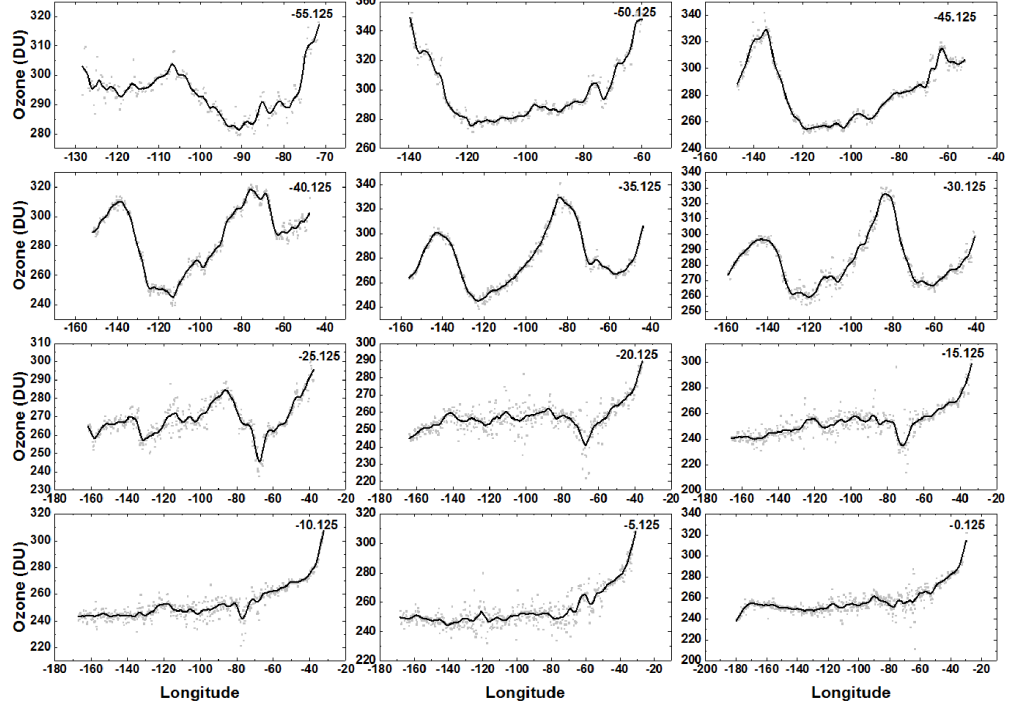
Figure 15. Southern Hemisphere: solid lines are approximately 30min averages in solar time at 18:38 UTC on 17 April 2016 for ozone variation between 0 and 55 ◦ S latitude in 0.25 ◦ latitude bands for 17 April 2016 at 17:36 UTC.